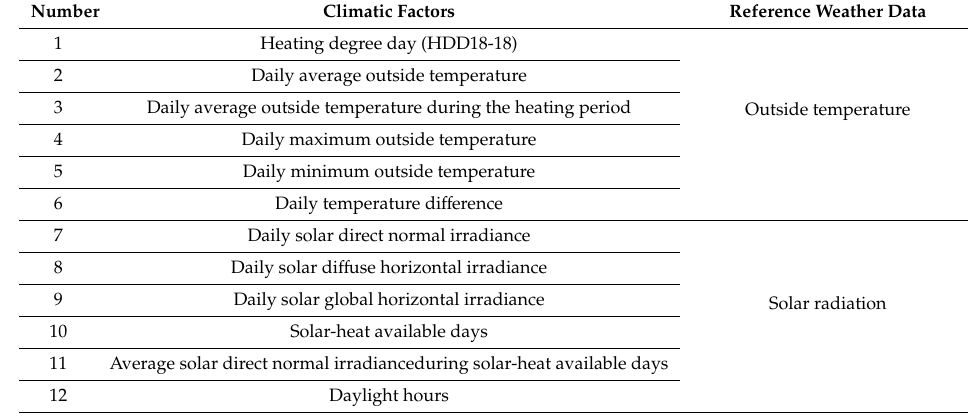
Table 3. Climatic factors.